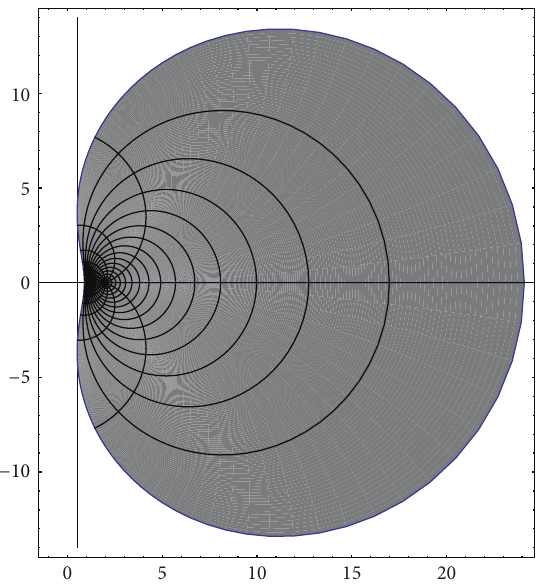
Figure 7: Image of |𝑧| ≤ √3/5 touches Re 𝑤 = 0.5